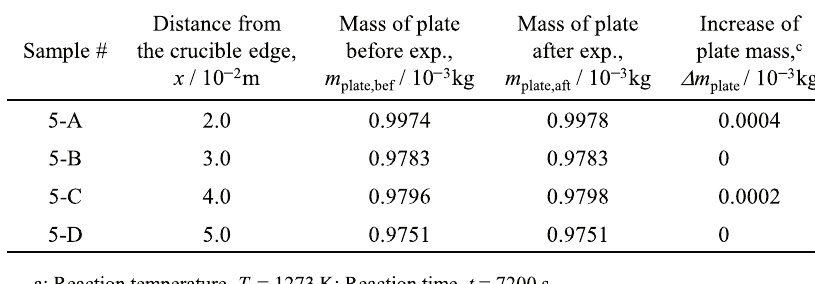
Table 7. Analytical results of the alumina plates set in the reaction tube.